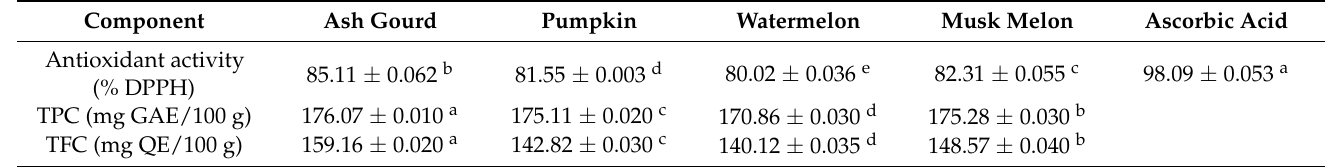
Table 5. Antioxidant activity, TPC and TFC of seeds (mg/100